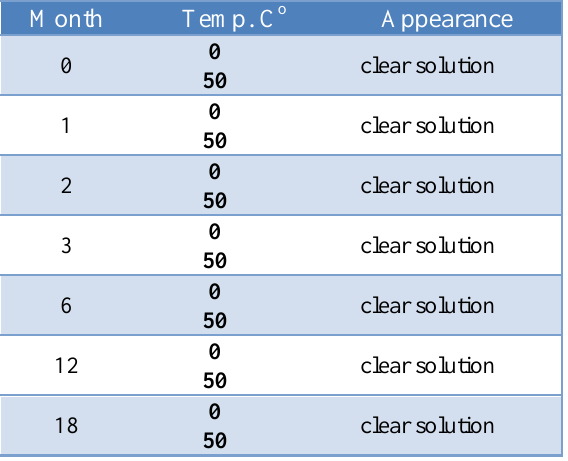
Table, 3 : Physical Stability of Composition Month Temp. C